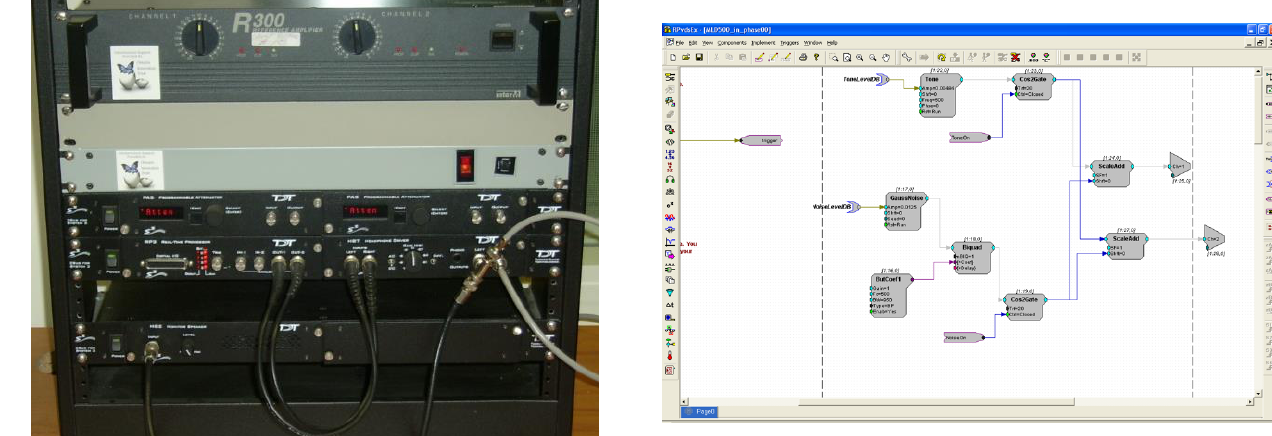
Figure 1. An example of a research-grade laboratory system. The panel on the left shows the equipment rack hosting the real-time signal processing and level control system from Tucker-Davis Technologies, while the right panel depicts a sample custom software “circuit” implementing a psychoacoustic test.